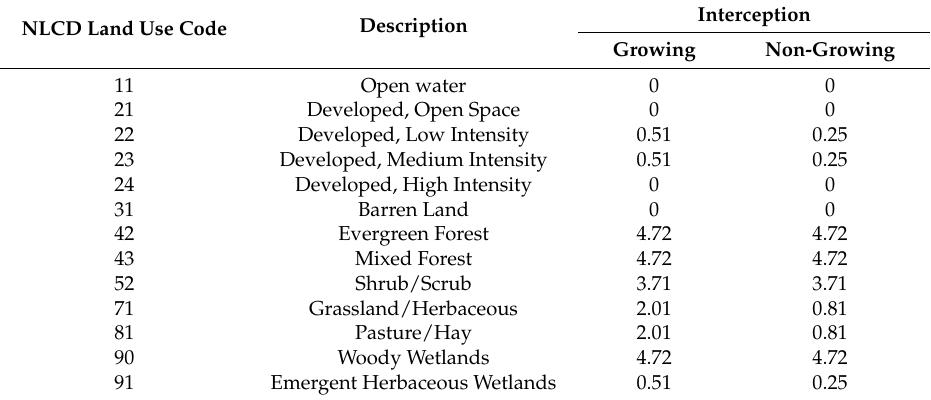
Table 2. Interception Storage values